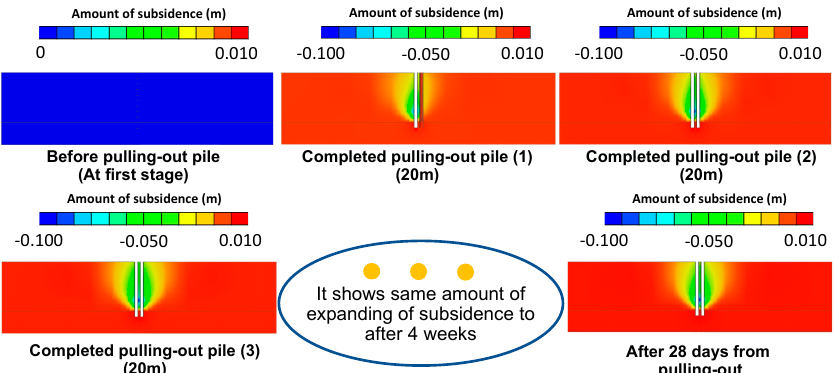
Figure 11. Deformation of the surrounding ground when three extraction holes of removed piles are hollow.